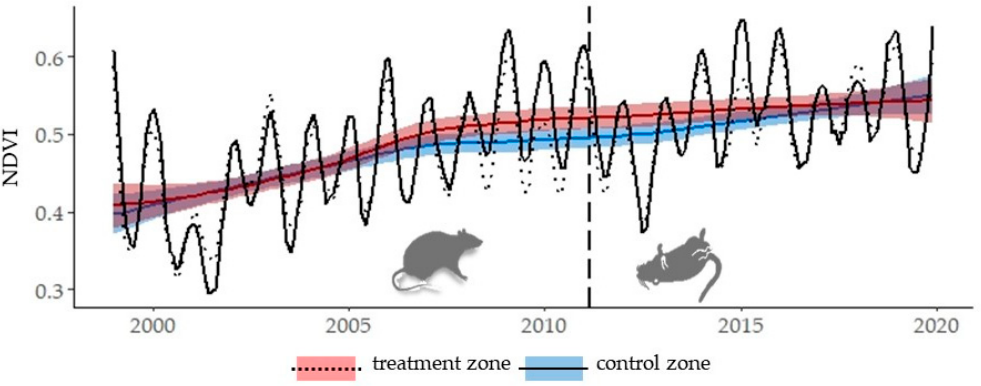
Figure 5. Monthly NDVI time series showing the average NDVI of the sampling plots for each zone. The colored lines (Red = Sa Dragonera; Blue = Mallorca Island, i.e., control zone) represent the trend throughout the study period, with a LOESS smoothing and standard deviation shown with the corresponding colors. The black lines represent the real data for each treatment (Solid = Sa Dragonera; Dotted= control zone), in which the seasonal variation can be observed. The dashed vertical line dates the rodent eradication campaign (February 2011).